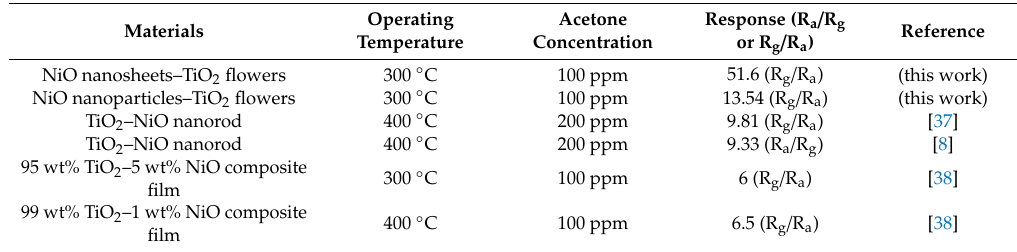
Figure 7. Gas-sensing response curves of various TiO 2 –NiO composites on exposure to various acetone vapor concentrations (50–750 ppm): ( a ) NST. ( b ) NPT. ( c ) Gas-sensing responses vs. acetone vapor concentrations for various TiO 2 –NiO composites. The gas sensing responses of the pristine TiO 2 flowers to 50 and 100 ppm acetone vapor are also shown for a comparison. ( d , e ) Cyclic gas-sensing response curves of the NST and NPT on exposure to 250 ppm acetone vapor, respectively. ( f ) Gas-sensing selectivity of NST. Table 1. Comparison of acetone vapor sensing responses of various TiO 2 –NiO composites [8,37,38].